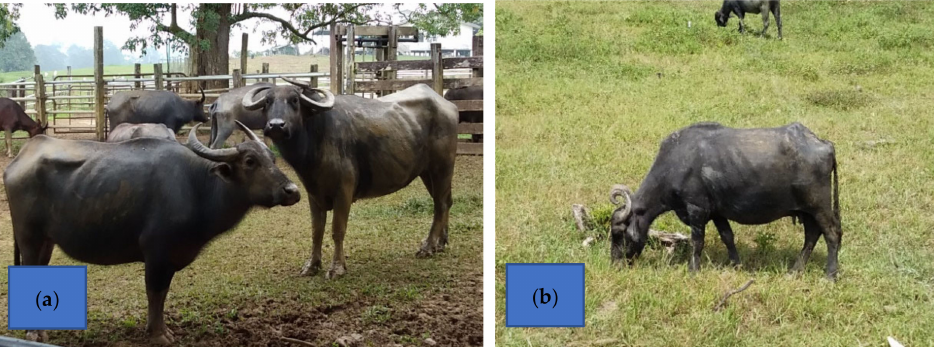
Figure 2. The crossbred and pure-bred Murrah buffaloes. ( a ) Crossbred buffalo and ( b ) pure-bred Murrah buffalo. Reprinted with permission from ref. [21]. Copyright 2021 Mohd Azmi et